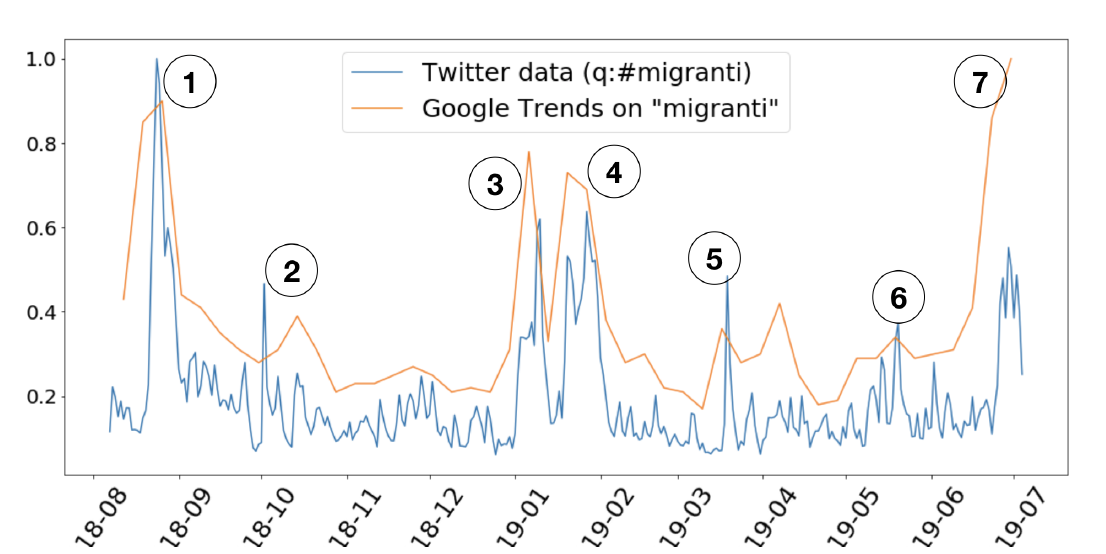
Figure 1. Comparison between Google Trends on ‘#migranti’ (orange line) and volume of tweets filtered on the same keyword. The more irregular pattern in the blue line is probably due to the much higher availability of Twitter data, that helps in providing a higher resolution picture of the trend. Google queries data was available on a weekly basis only. The spikes in the data are due to the following events: (1) a NGO ship held outside of a harbour for a long time and finally let dock (August 2018), (2) the arrest of Mimmo Lucano, a City Mayor accused of favouring illegal immigration (October 2018), (3–4) a minor arrival highly covered by the news media and the International Memorial Day (January 2019), (5) seizure of the Mare Jonio NGO ship (March 2019), (6) intense month of arrivals on the Italian coasts (May 2019) and (7) arrest of the NGO ship Captain Carola